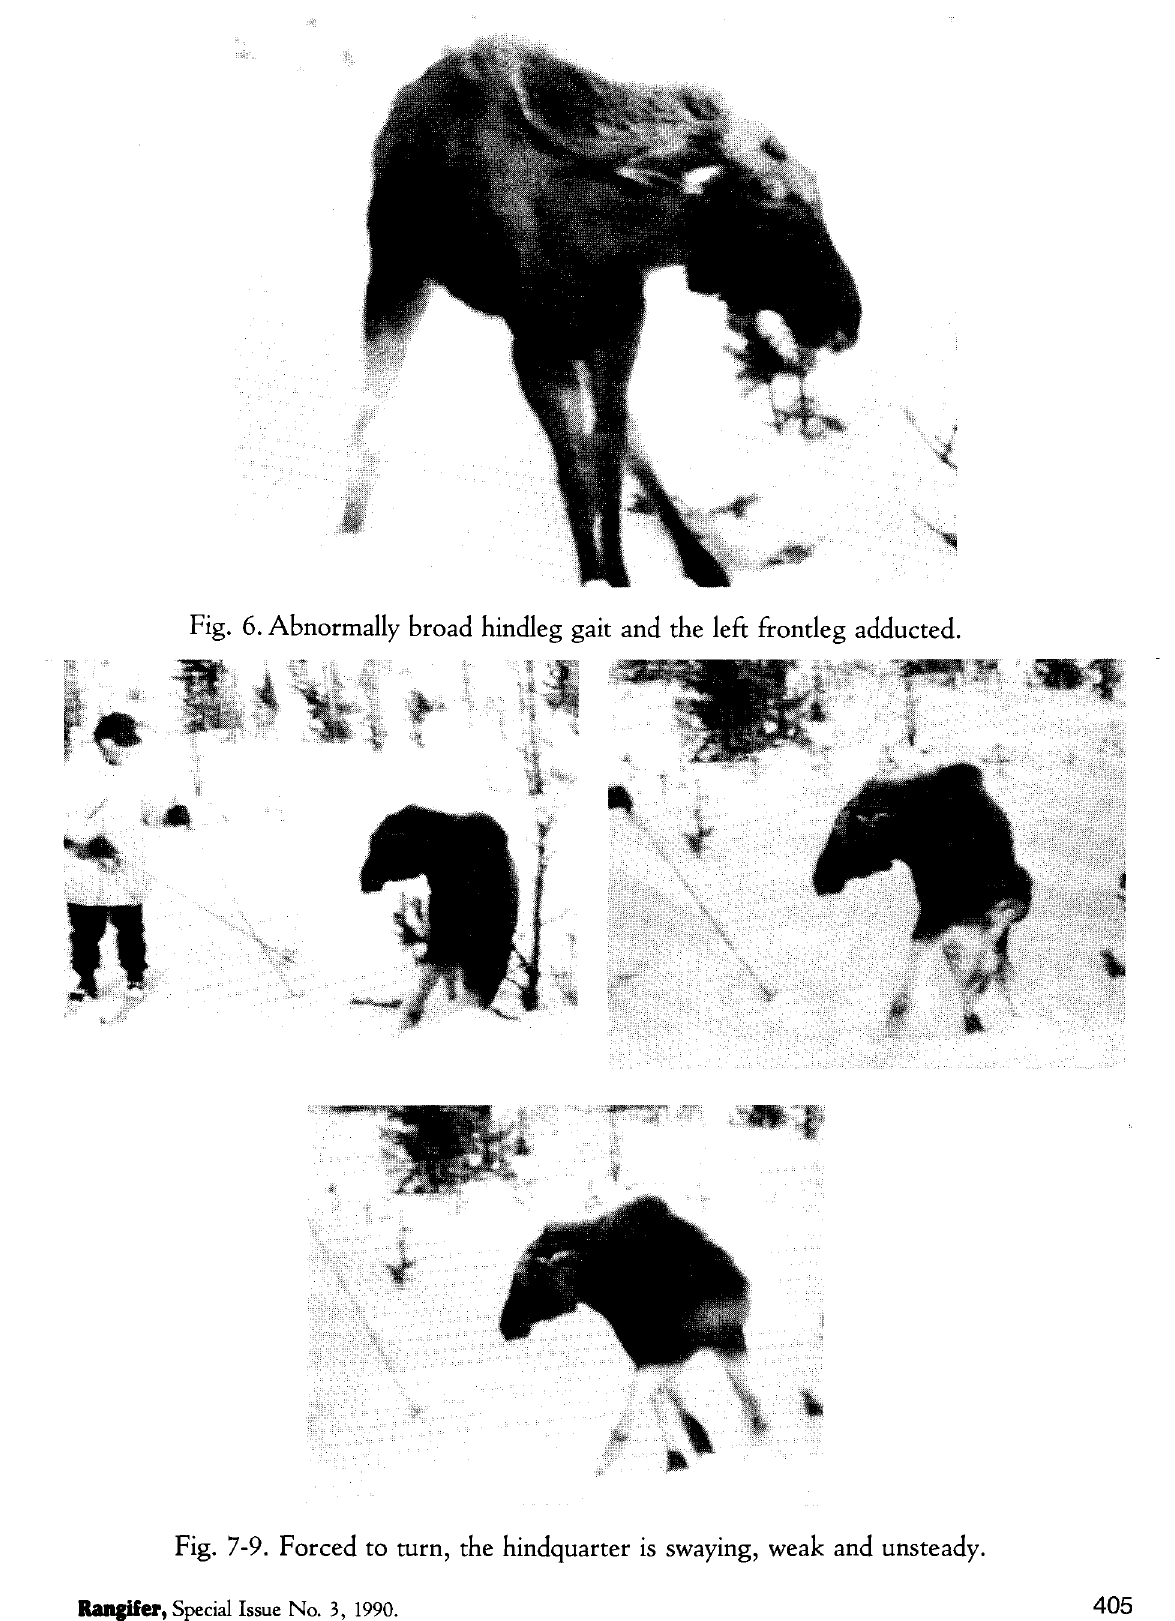
Fig. 7-9. Forced to turn, the hindquarter is swaying, weak and unsteady. Rangifer, Special Issue No. 3,